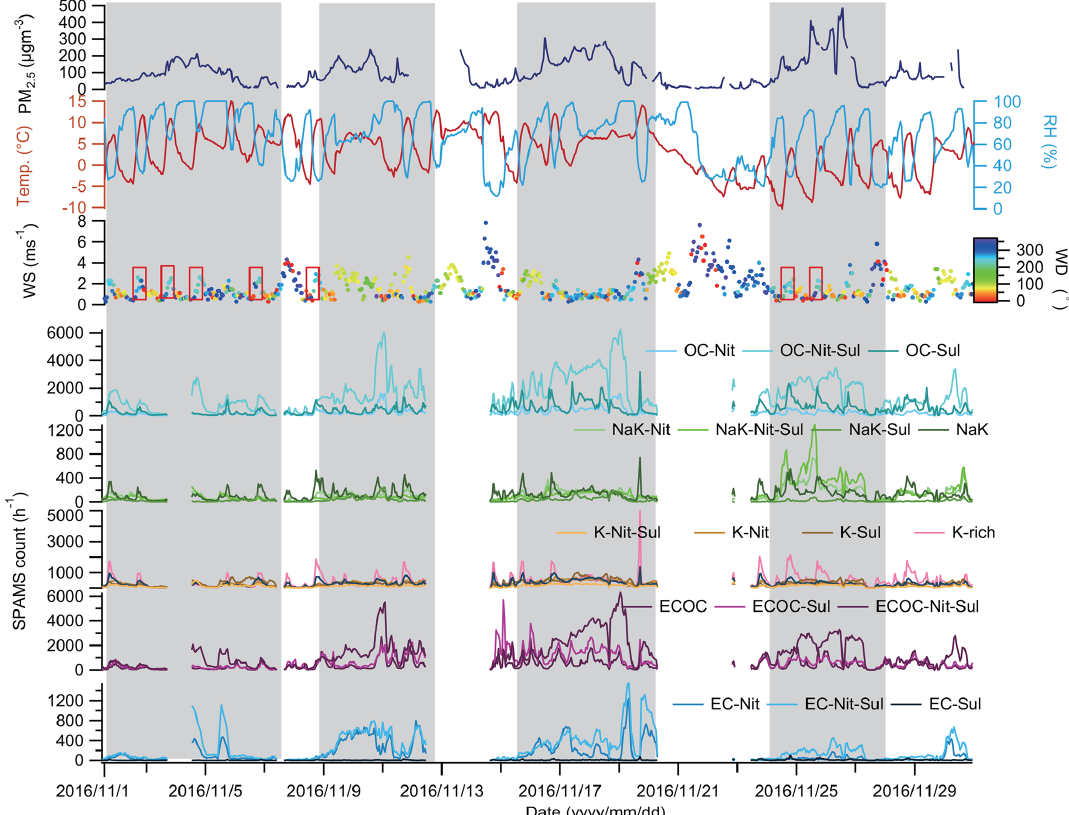
Figure 4. Time trends of PM 2 . 5 , temperature, relative humidity, wind direction (WD), wind speed (WS), and single-particle types at PG. The rectangles indicate the transport of regional